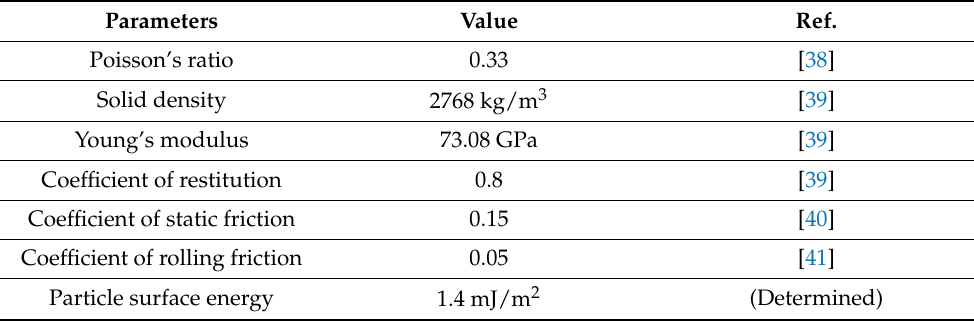
Table 2. The DEM parameters used in the flowability simulations.